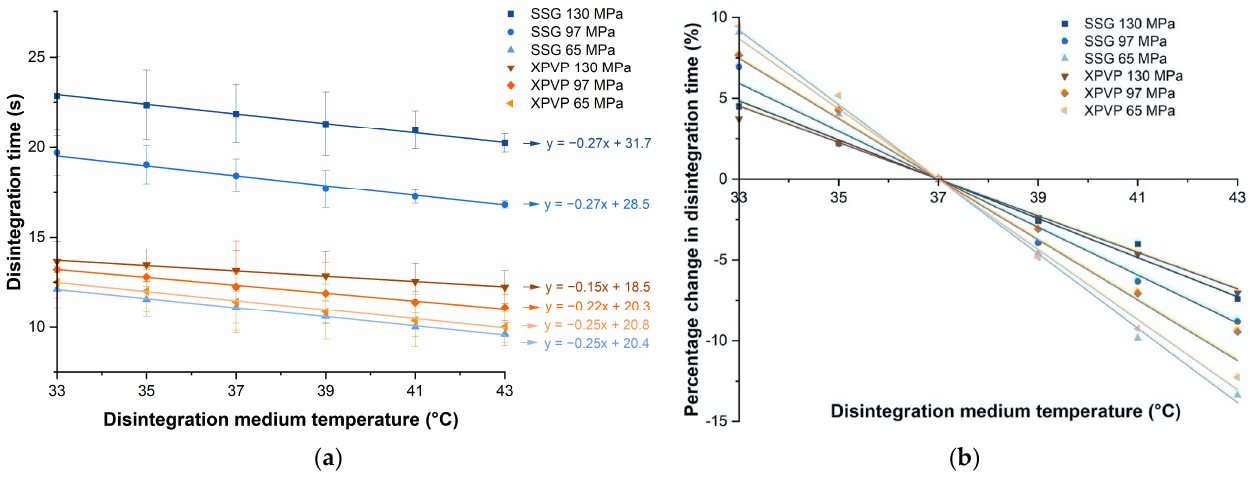
Figure 2. Plots of ( a ) disintegration time against disintegration medium temperature and ( b ) percentage change in disintegration time against disintegration medium temperature for tablets consisting of SSG and XPVP, produced at different compaction pressures. Note: All trend lines drawn are best fit lines. Table 1. Tensile strength and porosity of tablets